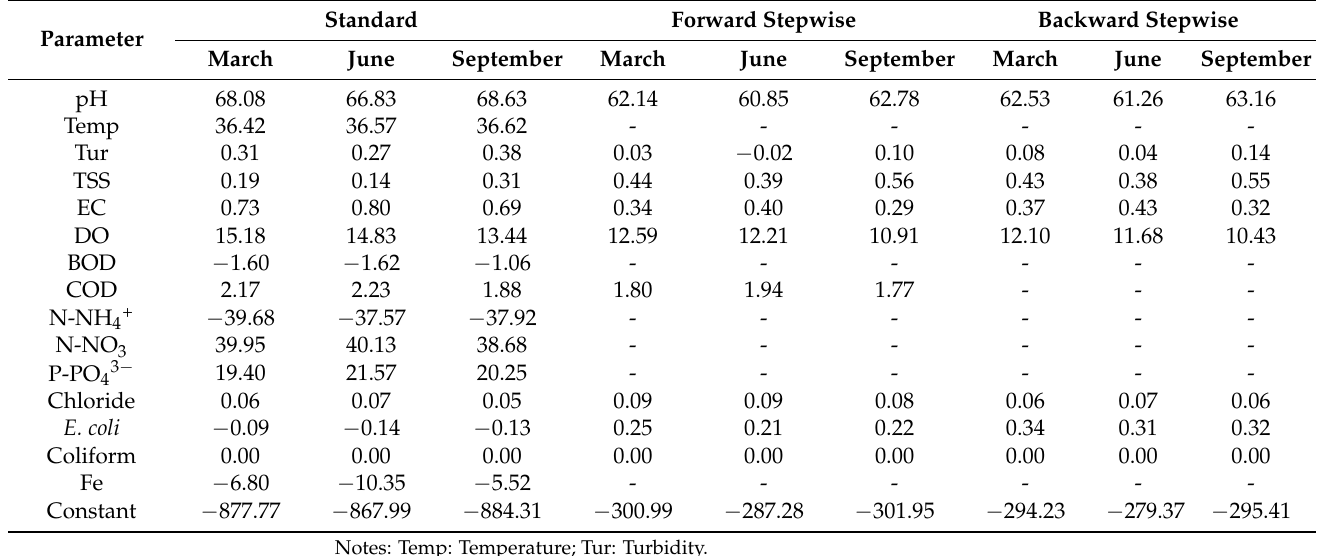
Table 2. Classification functions for discriminant analysis of temporal variations.